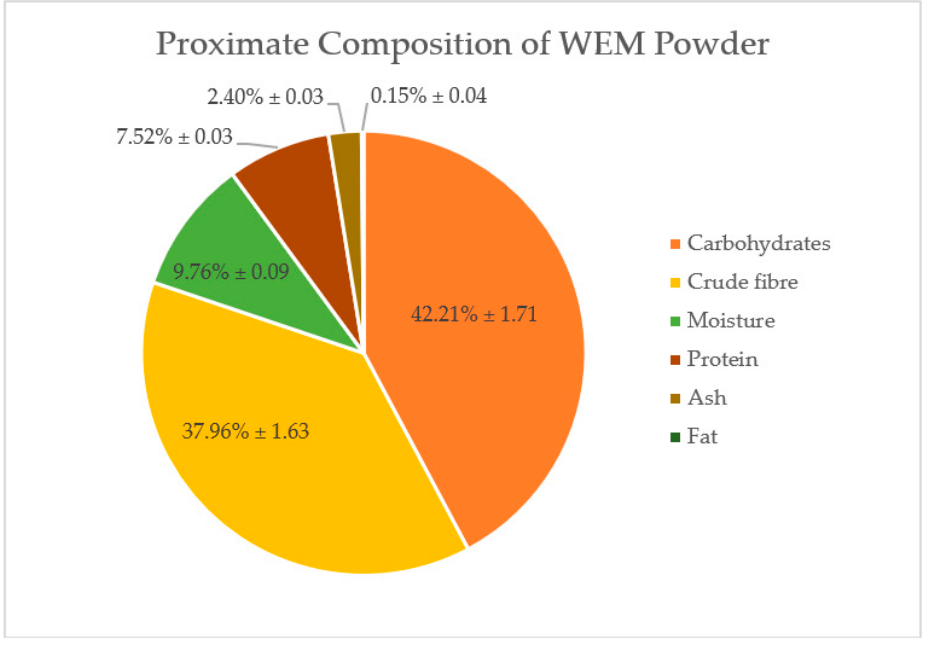
Figure 1. The proximate composition of WEM ( A. cornea ) powder on a dry weight basis was expressed as means ± standard deviation ( n = 3), WEM = wood ear mushroom.